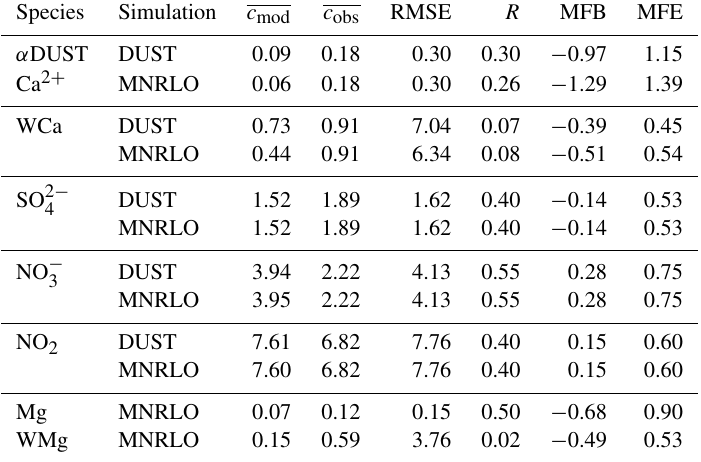
Table 5. Daily mean surface concentrations and wet-deposition fluxes of gas and aerosols. Comparisons are presented between EMEP measurements and CHIMERE modelling. Aerosol species are mineral dust, calcium (Ca 2 + , micrograms per cubic metre), sulfate (SO 2 − µgSm − 3 ), nitrate (NO − , µgNm − 3 ), and nitrogen oxides (NO 2 , micrograms per cubic metre). In the case of DUST, the calcium concentration 3 is estimated by using the surface concentrations of mineral dust multiplied by a factor α = 0 . 06. In the case of MNRLO, the calcium and magnesium (Mg, micrograms per cubic metre) is explicitly modelled as well as their respective wet deposition – WCa and WMg (µgm − 2 d − 1 ).